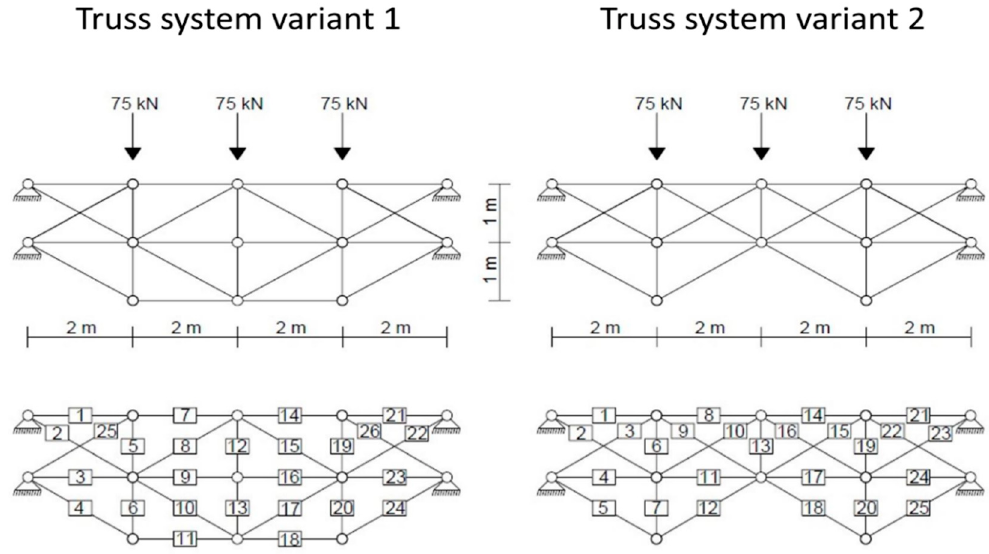
Figure 4. Description of the investigated system and labelling of individual elements.